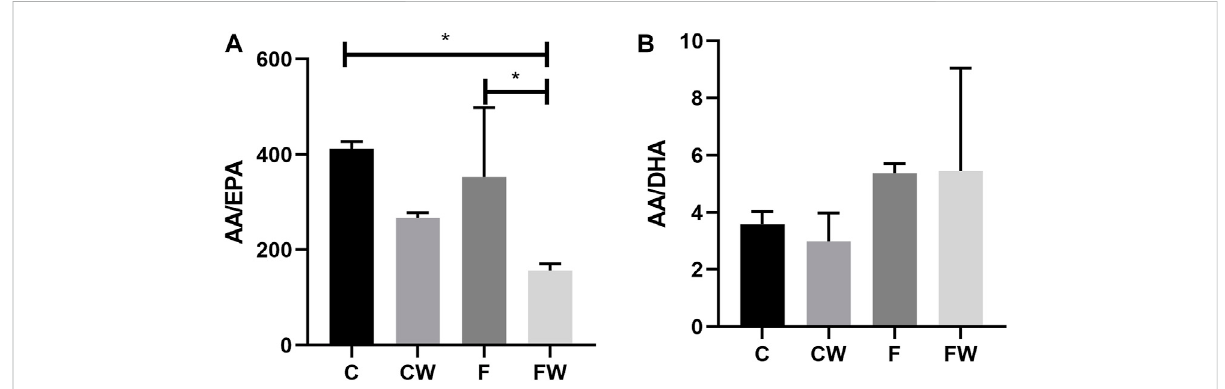
FIGURE 1 Effects of fructose-rich diet and walnut supplementation on the (A) AA/EPA and (B) AA/DHA ratio in total heart lipid pool of experimental rats. Valuesare meanswithstandarddeviationsrepresentedbyvertical barsfor3animalspergroup. C — animalsonstandard laboratory chow, F — animals fed a fructose-rich diet, CW — animals on standard laboratory chow and walnut supplementation, FW — fructose-fed animals on walnut supplementation, * p < 0.05.